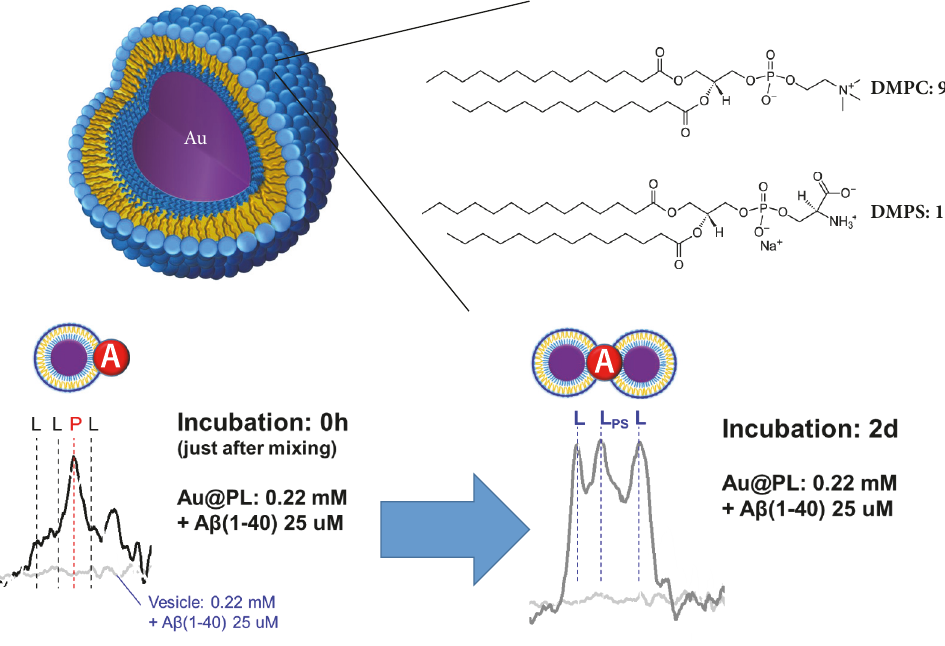
Figure 5: Summary of this